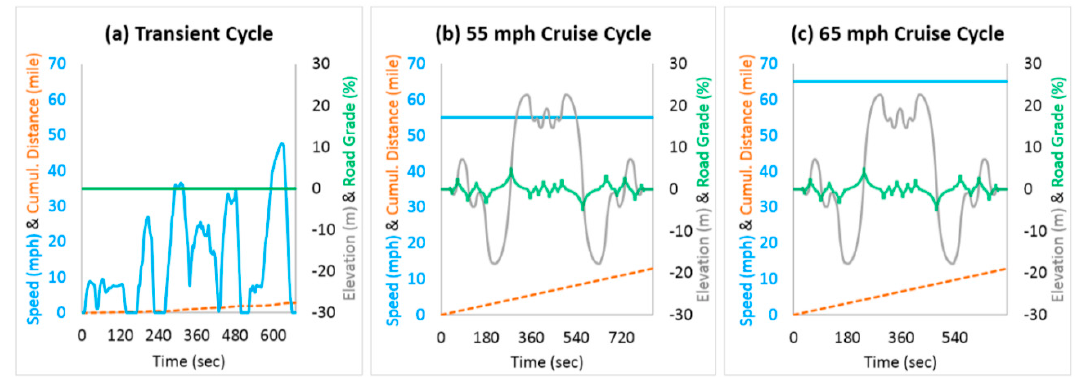
Figure 6. Drive cycles used in this study to estimate fuel consumption of trucks.